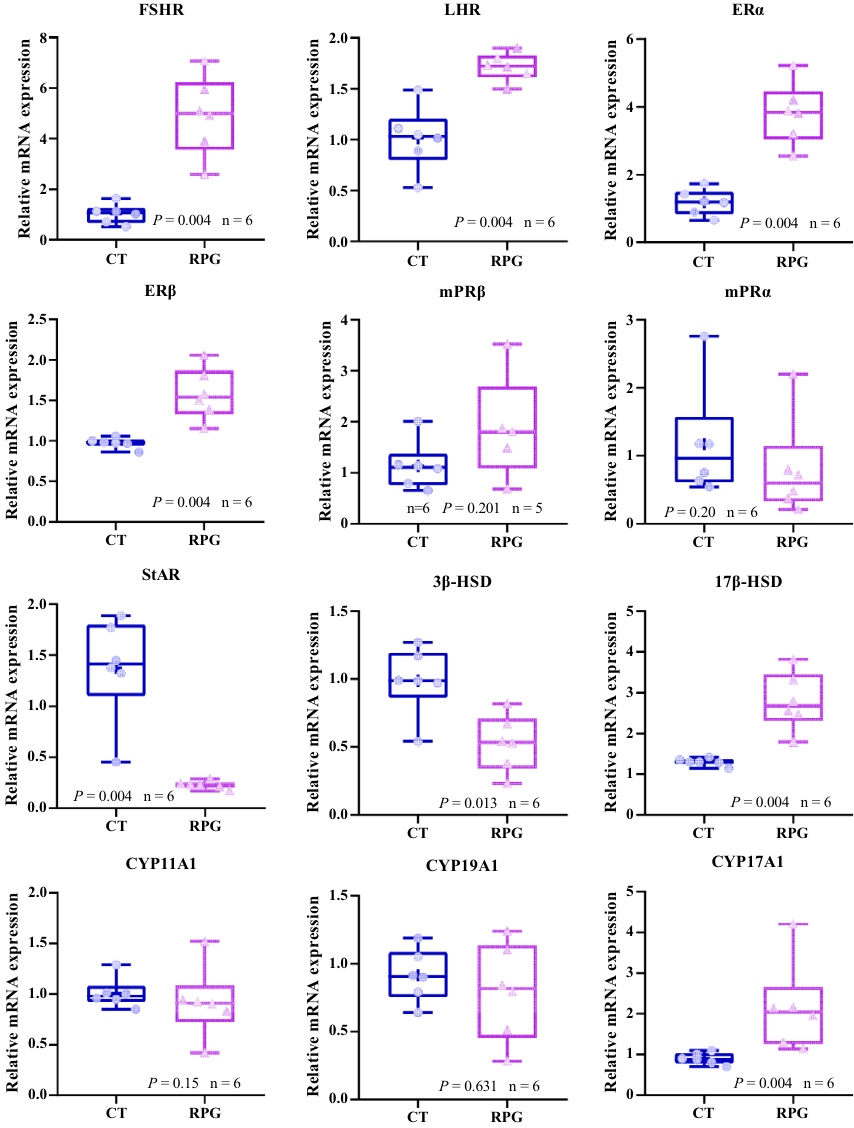
Figure 3. Box and whisker plots of the FSHR, LHR, ERα, ERβ, mPRα, mPRβ, StAR, 3β-HSD, 17β-HSD, CYP11A1, CYP19A1 and CYP17A1 gene expression in ovarian tissue from postpartum dairy cows that show significant ( P < 0.05) between control diet and rumen-protected glucose